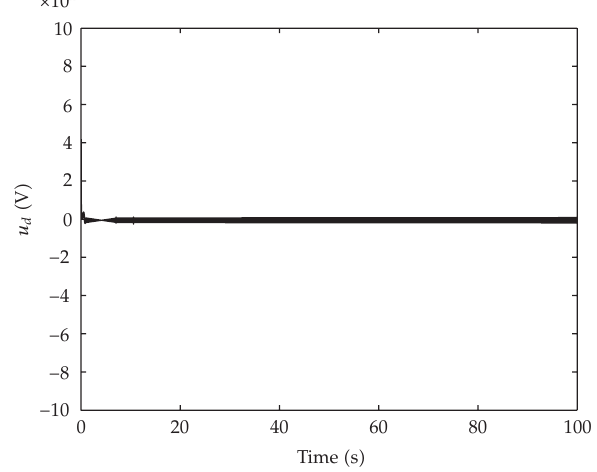
Figure 8: The curve of the controller u d